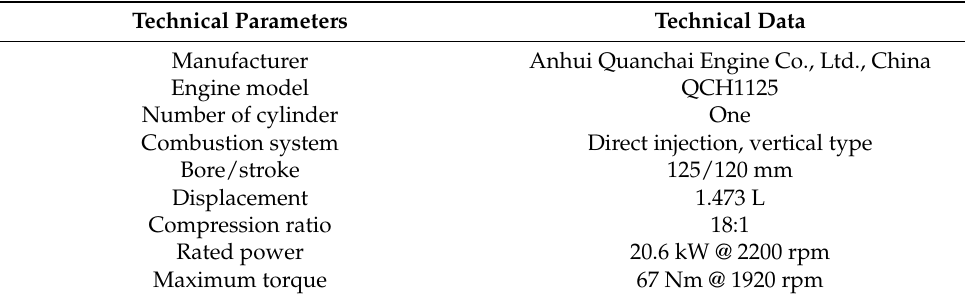
Figure 1. Schematic and photographic representation of the diesel engine test system. Table 1. Specification of the test engine.